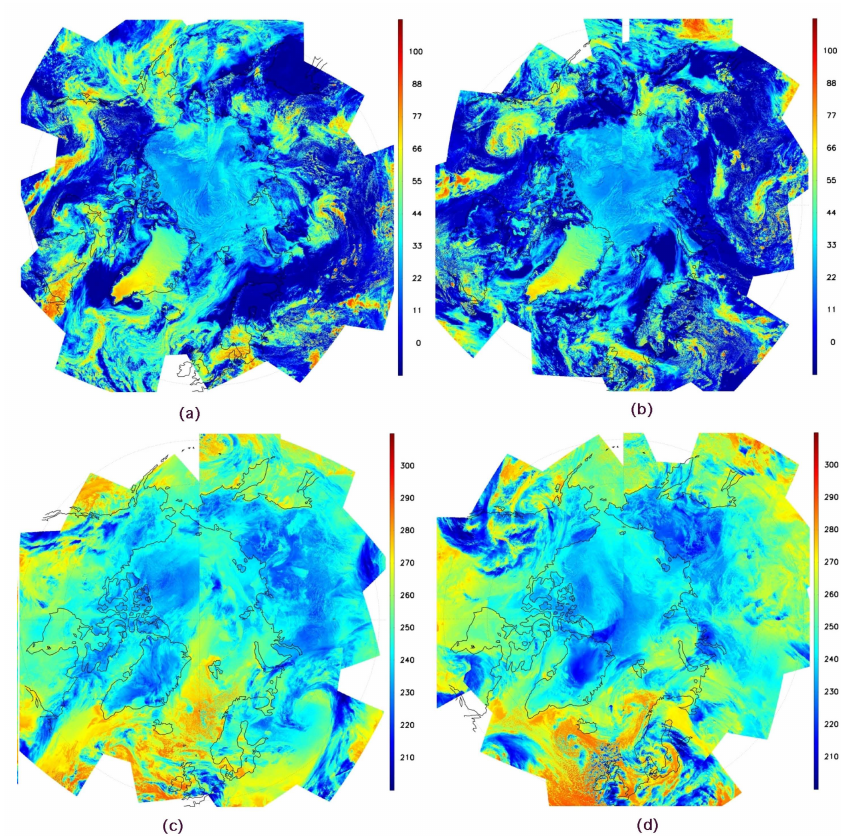
Figure 3. An example of APP processing applied to MODIS data, for comparison to the APP composites in Figure 4. Statistics are given in the text. Top: MODIS 0.64 µ m reflectance over the Arctic on day 182 of 2003 ( a ), and on day 182 of 2007 ( b ) at 14:00 local solar time (LST). Bottom: MODIS 11 µ m brightness temperature on day 1 of 2003 ( c ), and on day 1 of 2007 ( d ) at 14:00